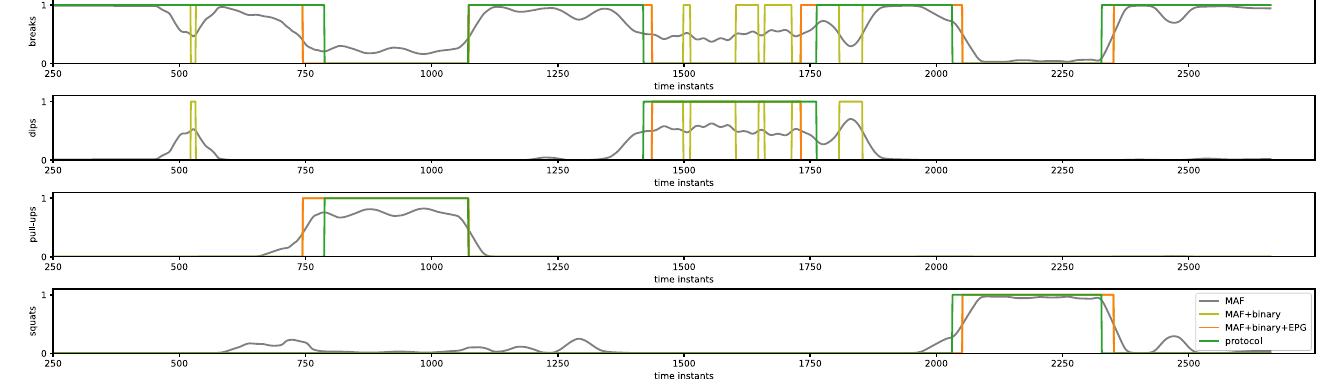
Table 8. The accuracies for single and all activities.